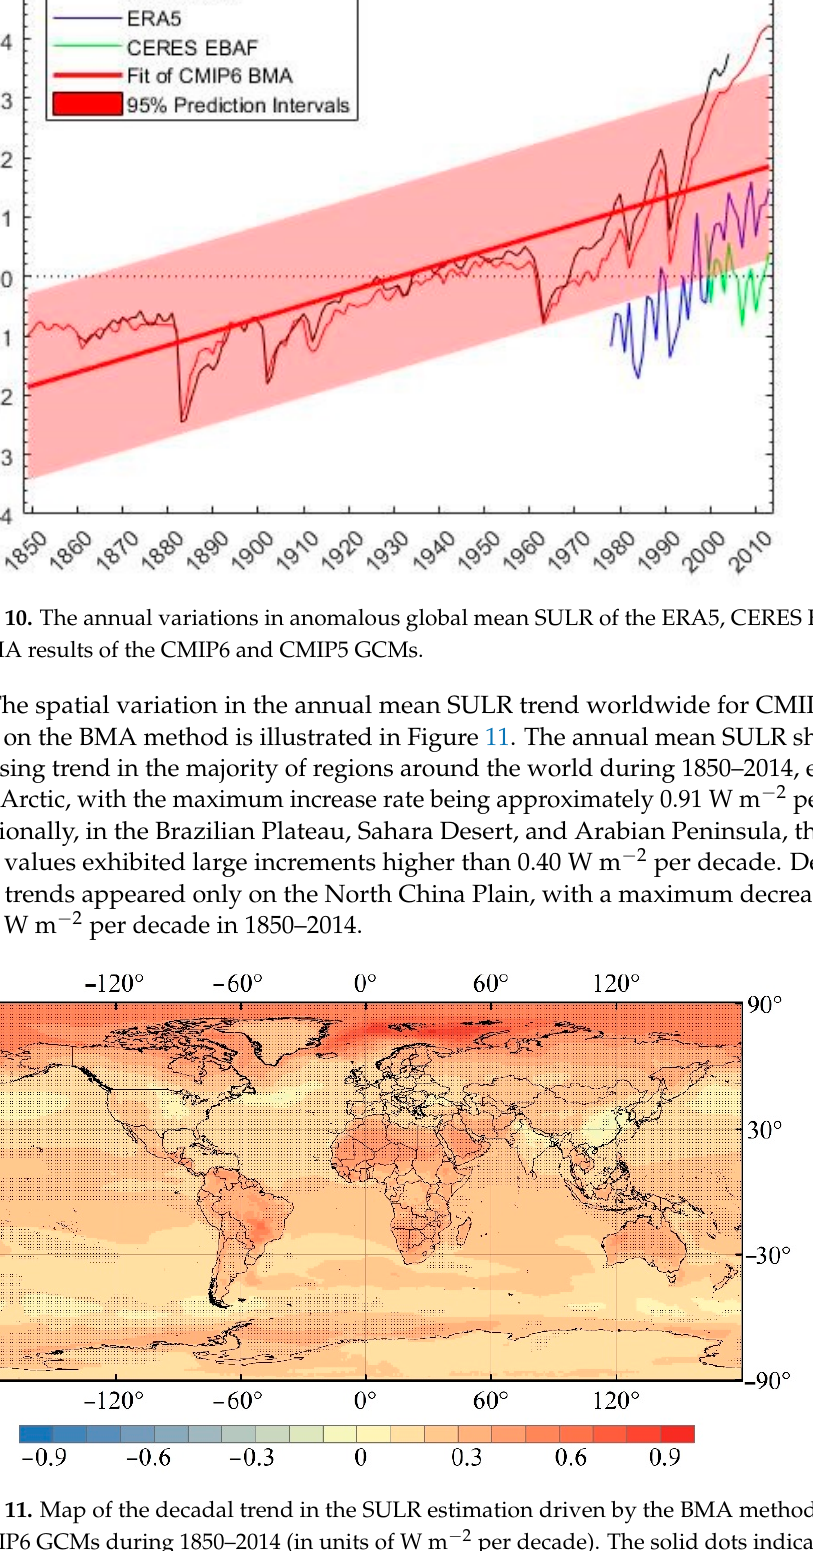
Figure 11. Map of the decadal trend in the SULR estimation driven by the BMA method based on 51 CMIP6 GCMs during 1850–2014 (in units of W m − 2 per decade). The solid dots indicate grids at 95%